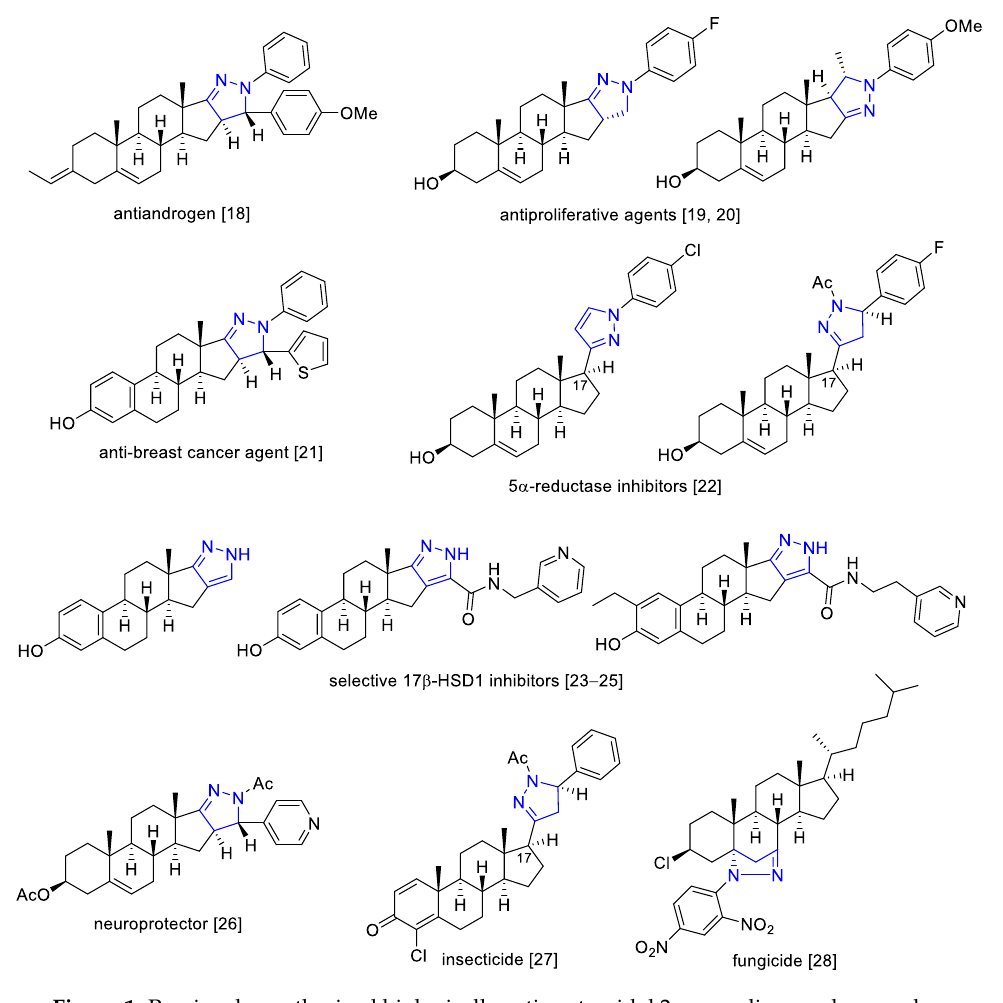
Figure 1. Previously synthesized biologically active steroidal 2-pyrazolines and pyrazoles.